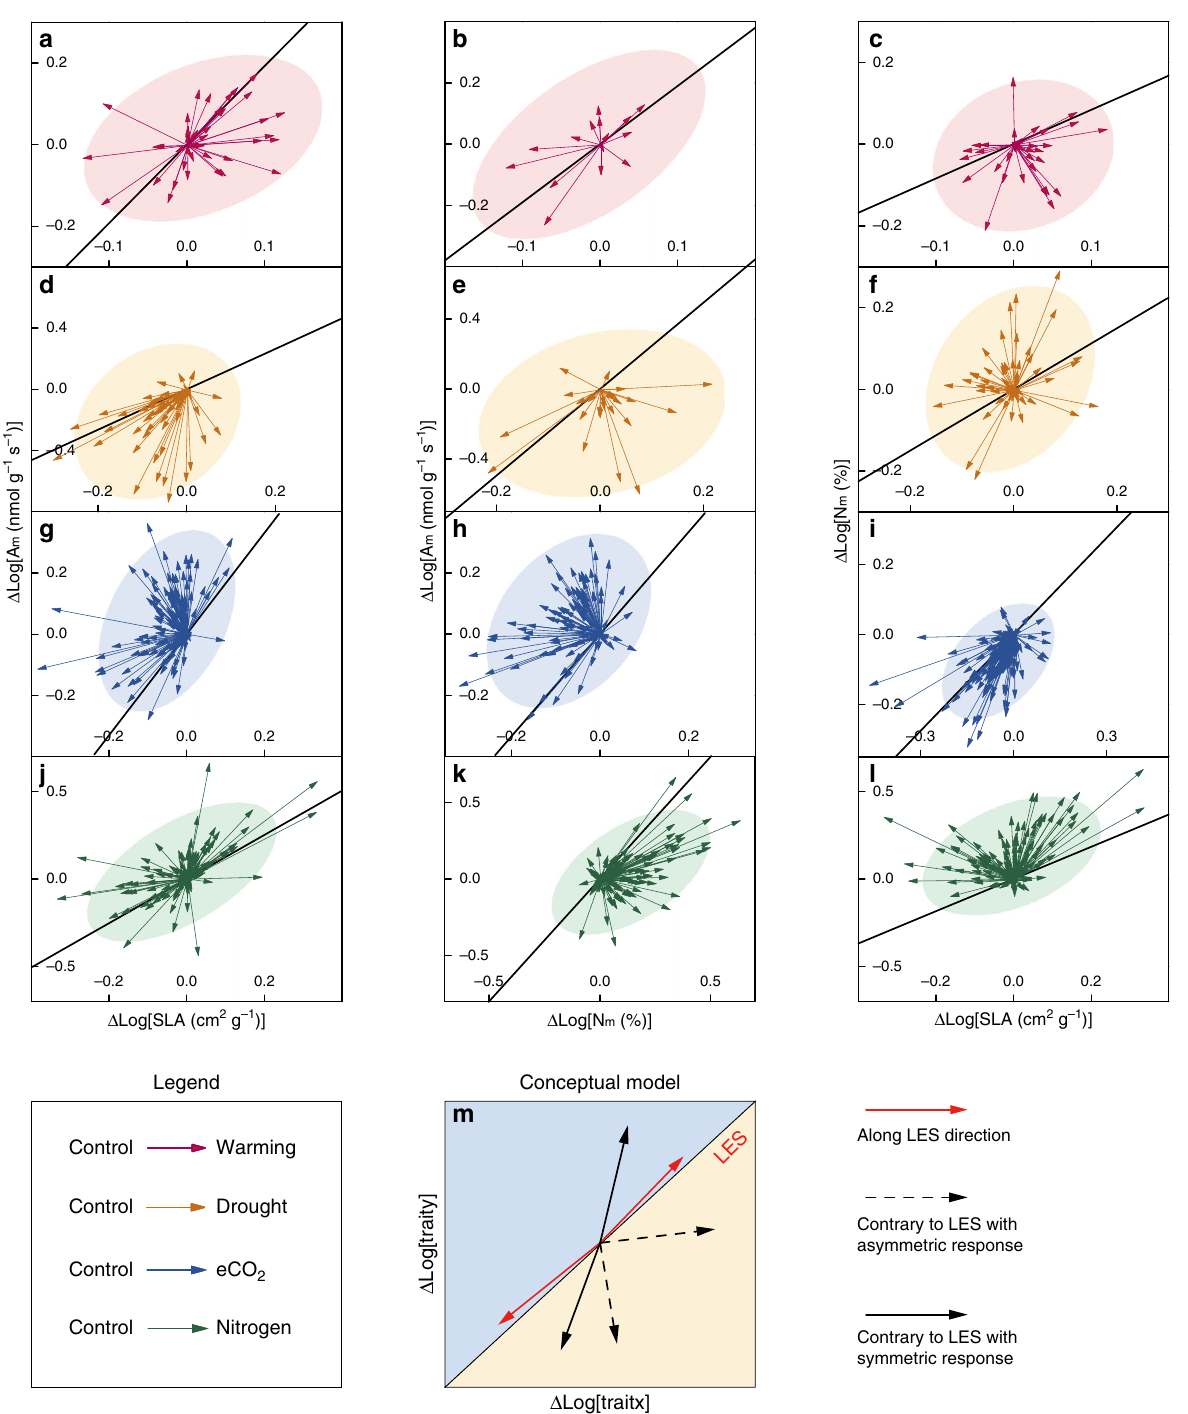
Fig. 3 Plasticity of species-level pairwise traits under global environmental changes. a – l Plasticity of species-level pairwise traits under global environmental changes (Supplementary Note 2). Each colored arrow represents the direction of one species. The bold black line represents the interspeci fi c leaf trait relationship. The colored ellipses are 95% con fi dence level of the scatters. m Conceptual model depicting three possible directions of pairwise traits: follow the LES direction (red arrows); contrary to the LES direction with asymmetric response (black dashed arrows); contrary to the LES direction with symmetric response (black solid line). The black solid line represents the LES direction. The arrows represent the major directions of the pairwise